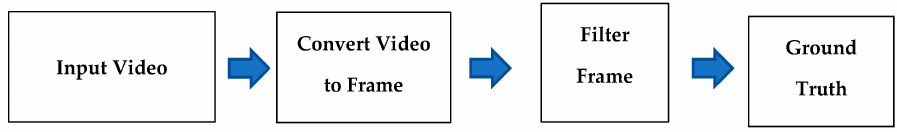
Figure 1. Pre-Processing. Figure 1.